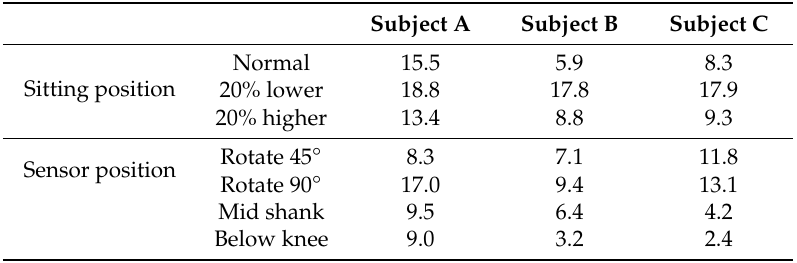
Figure 3. Mean ± SD of the five normalized movement cycles for the BPMpathway (full blue